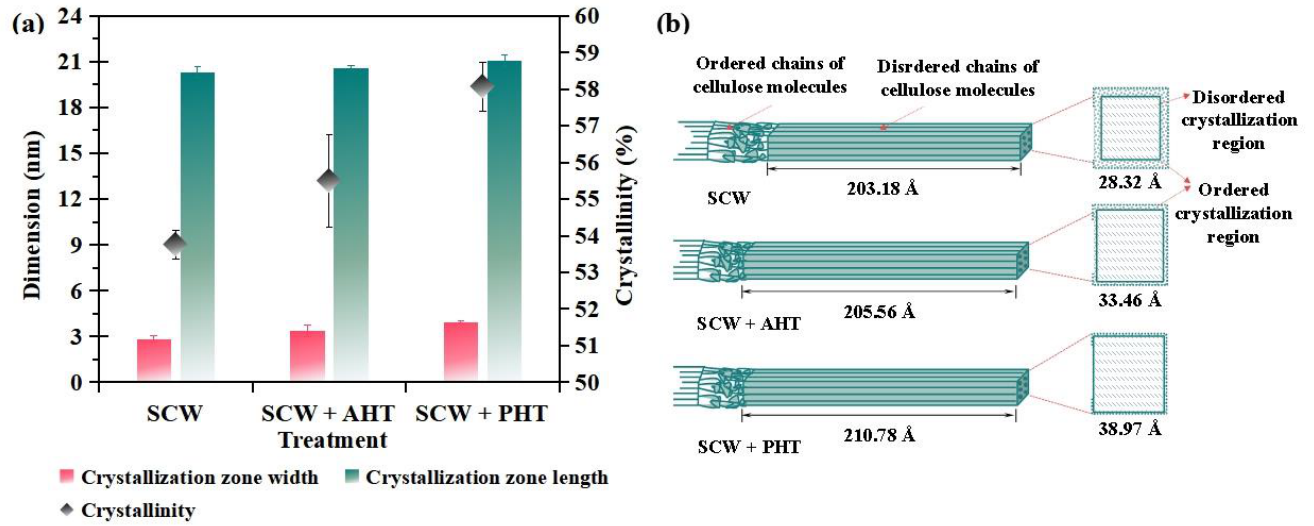
Figure 6. The crystallinity index and crystallite dimension of cellulose of the SCW, SCW + AHT, and SCW + PHT ( a ). A possible model for cellulose chains in the cross-section and longitudinal direction ( b ). SCW, surface-compressed wood without post-treatment; SCW + AHT, surface-compressed wood with atmospheric steam heat treatment; SCW + PHT, surface-compressed wood with pressurized steam heat